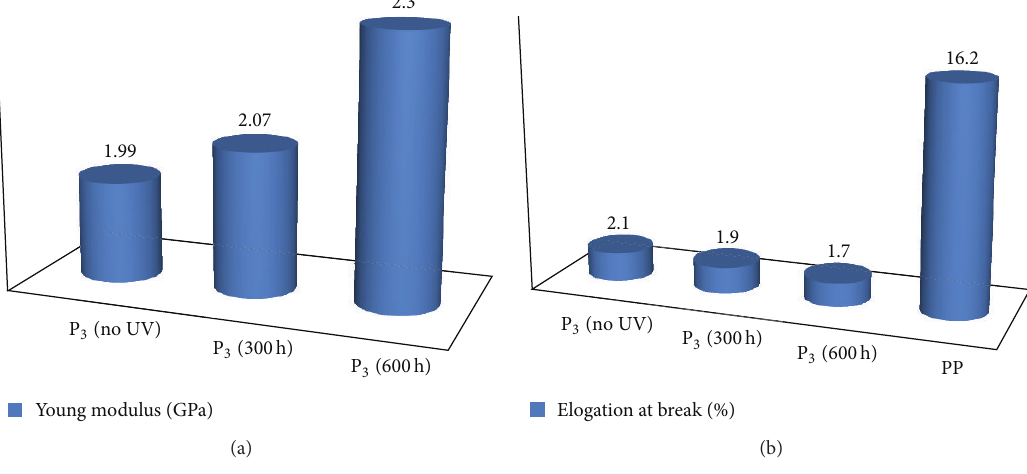
Figure 6: Young’s modulus (a) and elongation at break